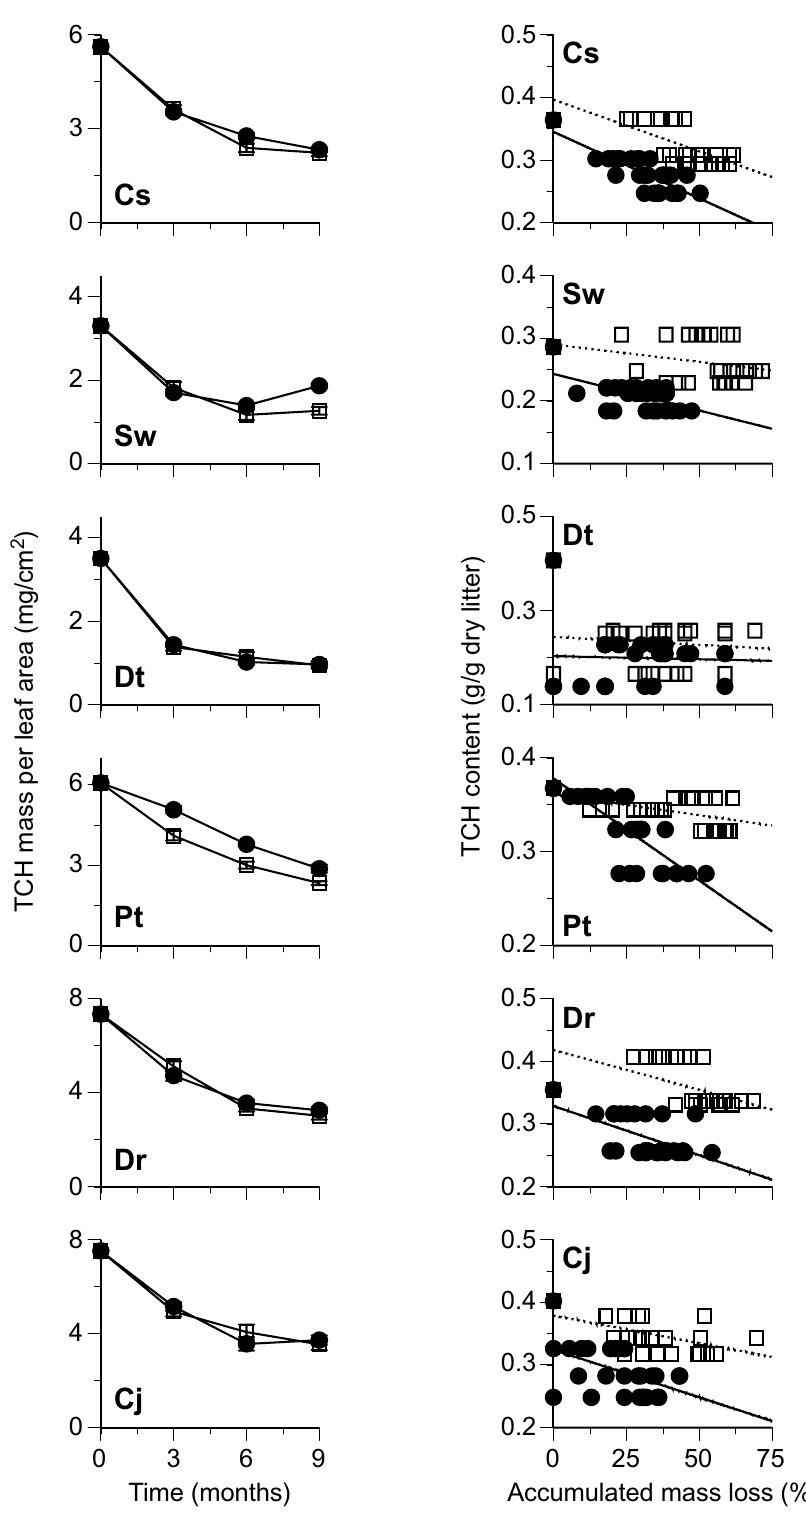
Figure 4. Changes in total carbohydrates (TCH) mass per leaf area (left) and relationship between accumulated mass loss and TCH content (right) in bleached (open square, dotted line) and nonbleached portions (filled circle, black line) during decomposition. Codes on the panels indicate the first letter of genus and species names of tree species. Bars indicate standard